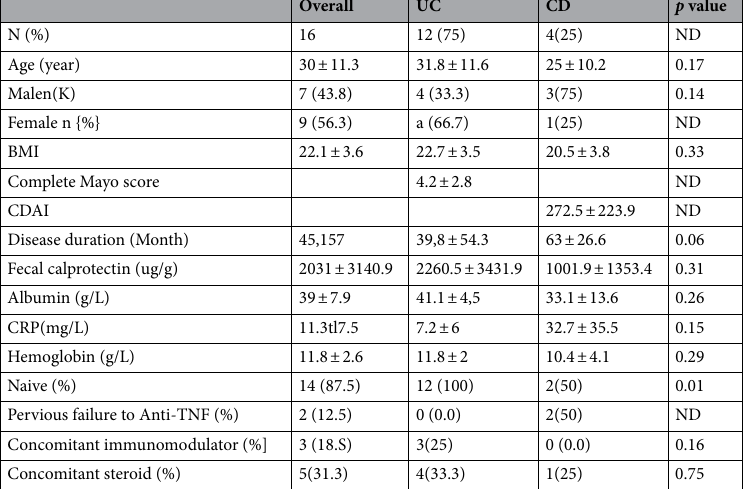
Table 1. Clinical characteristics and patient demographics at baseline. ANTI-TNF Anti-tumor necrosis factor-α, N Number of patients, UC Ulcerative colitis, CD Crohn’s disease, mean (standard deviation), ND Not